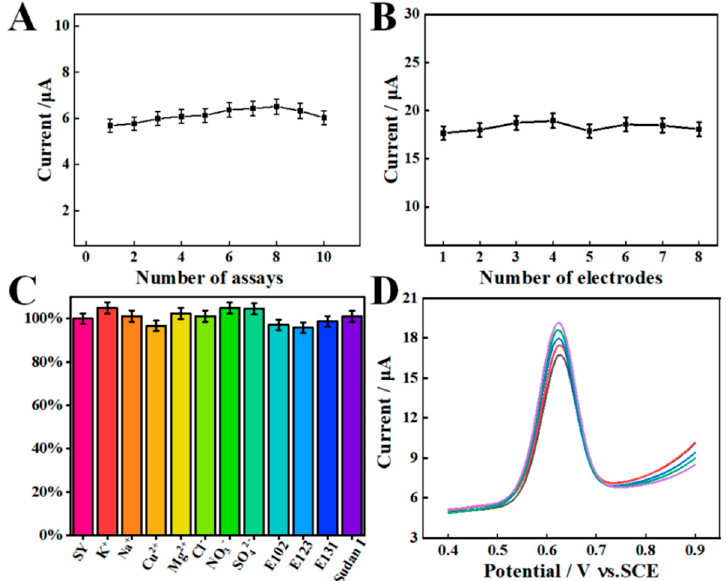
Figure 8. ( A ) Repeatability and ( B ) reproducibility of the AGCE sensor towards 10.0 µ M SY. ( C ) Anti-interference of the AGCE for the detection of 10.0 µ M SY. ( D ) SWV response of SY in the beverage samples in a 1.0 M PBS (pH 7.0). Table 2. Determination of SY in the beverage samples ( n =